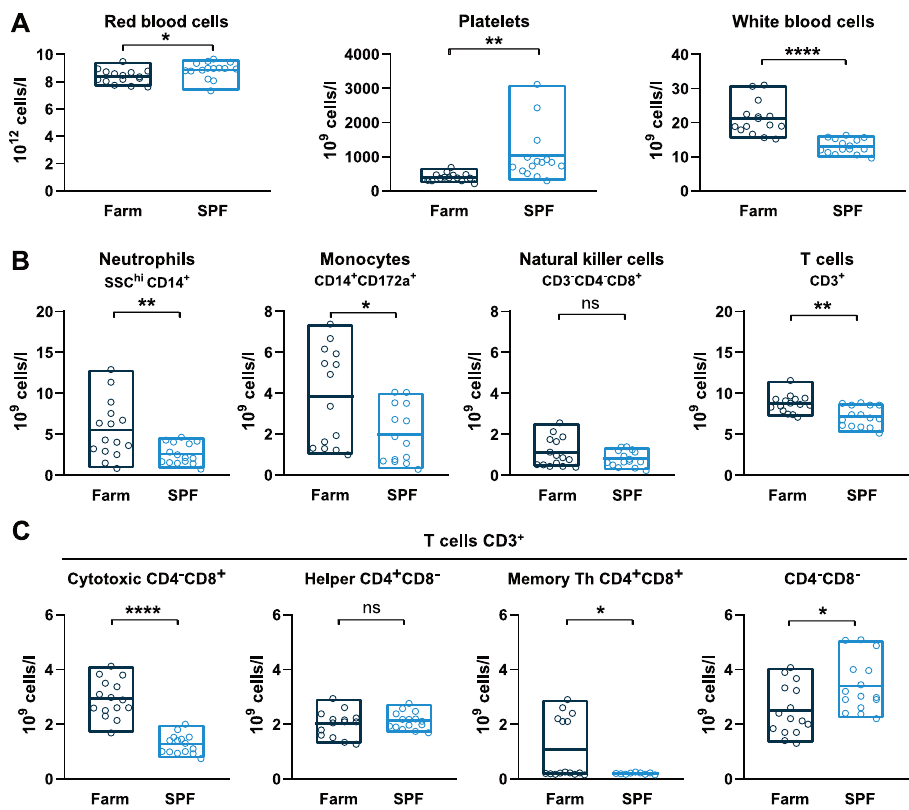
Fig 1. Basal hematologic and immune profiles of SPF and farm pigs. (A) RBC, PLT, and WBC counts in uninfected pigs. (B) Immunophenotyping of blood leukocytes (CD45 + ). The percentage of each subset was determined by flow cytometry gating (S2 Fig) and the absolute numbers were calculated using WBC counts. (C) T cell subsets gated from CD3 + T cells. (A, B, C) Each point represents the value for a single pig, horizontal lines and boxes represent the mean and range. Data are from 2 independent experiments (n = 15 per SPF or farm groups) and were analyzed using unpaired t test; ns, not significant; � p < 0.05; �� p < 0.01; ���� p < 0.0001.